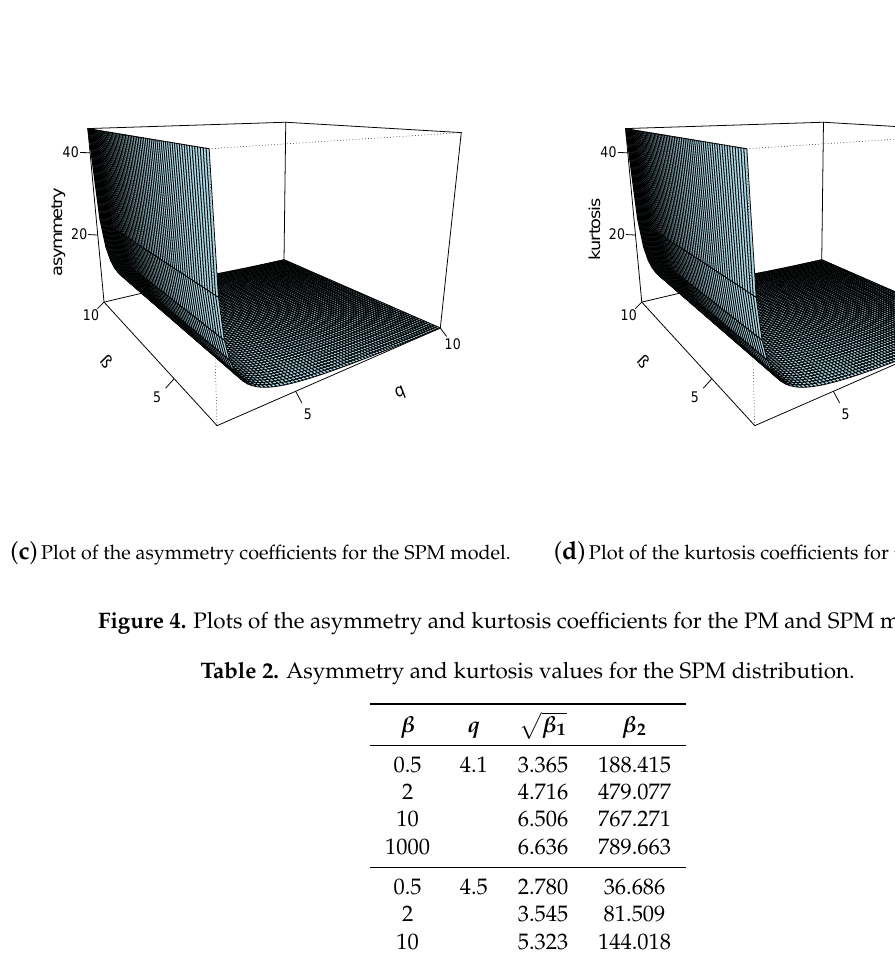
( a ) Plot of the asymmetry coefficients for the PM model. ( b ) Plot of the kurtosis coefficients for the PM model.